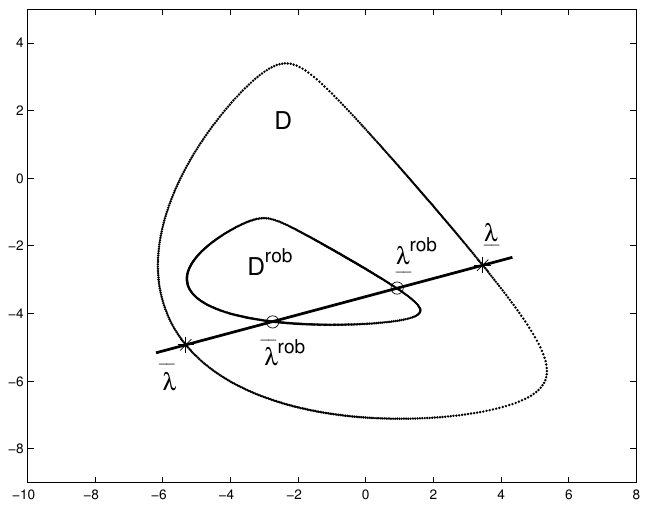
Figure 2. Feasible and robustly feasible linear matrix inequalities (LMI) domains.